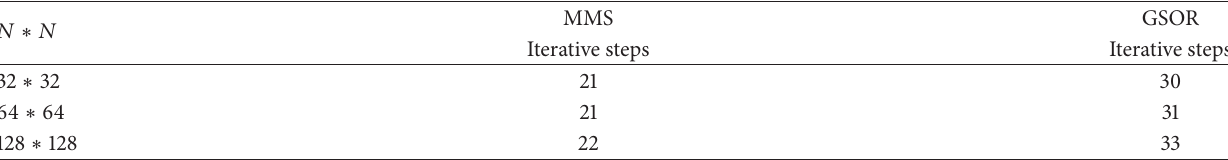
Table 3: Comparison of MMS and GSOR with preconditioned methods ( 𝐻 -matrix).